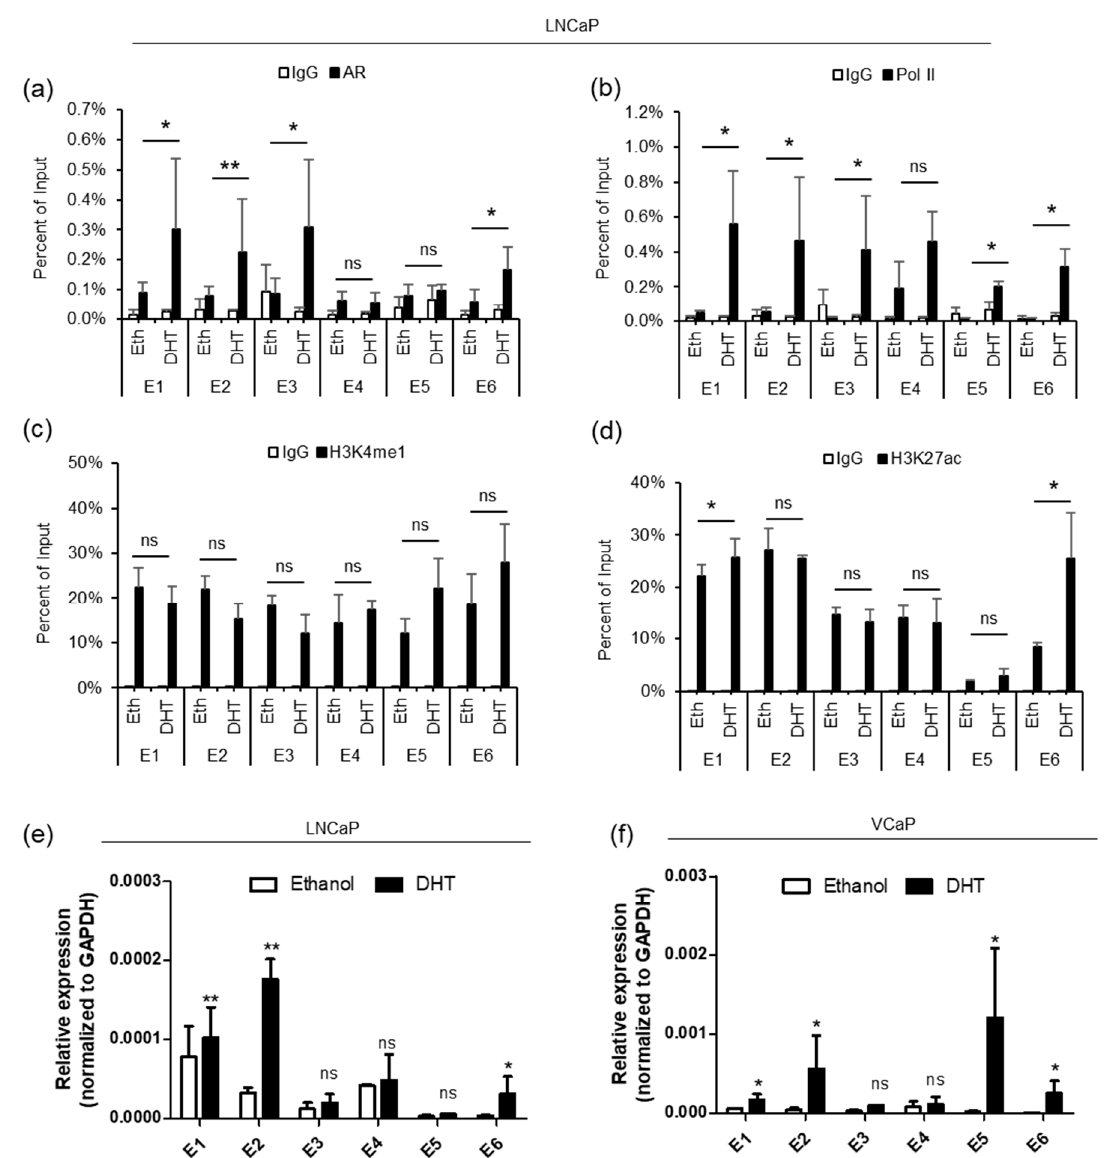
Figure 2. AR binds to the enhancers, between TMPRSS2 and PRCAT38 , recruiting Pol II and H3K27ac to activate the enhancers. ( a – d ) ChIP-qPCR in LNCaP cells before and after DHT treatment showing AR, RNA polymerase II, H3K4me1 and H3K27ac enrichment over the potential enhancer regions. Data are shown as the mean ± SD (n = 3). * indicates a significant change of the DHT treatment over the vehicle. ( e – f ) eRNA transcription from potential enhancers before and after DHT treatment in LNCaP and VCaP. *: P < 0.05, **: P < 0.01, ns: not